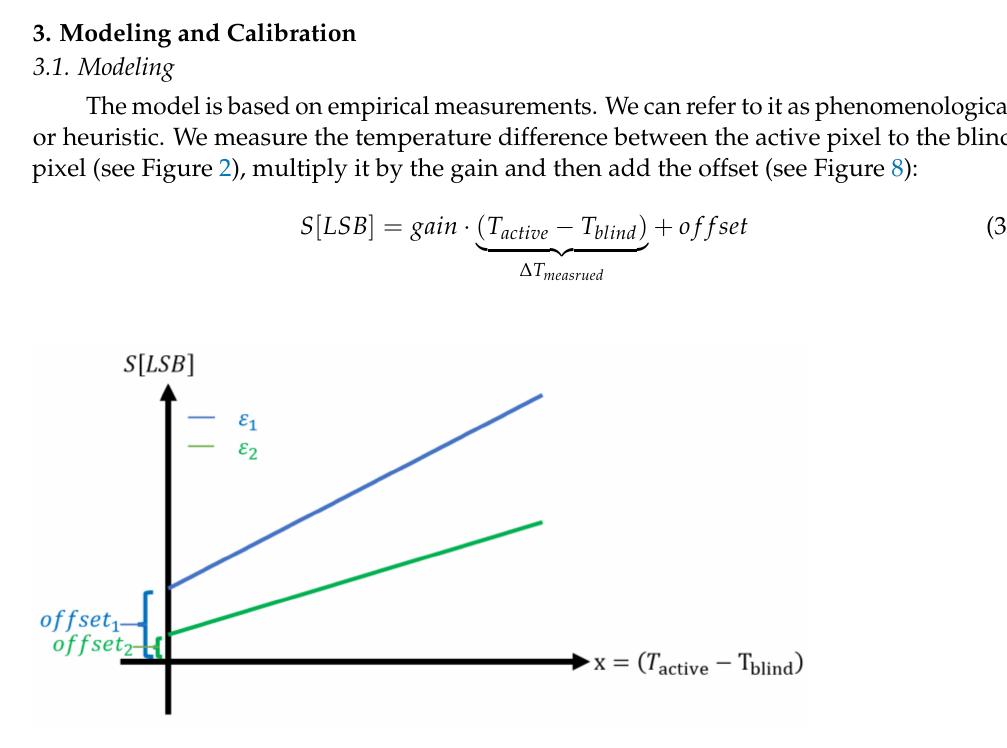
Figure 8. Schematic presentation of the measured signal, illustrating the gain and the offset. The gain is the slope of the